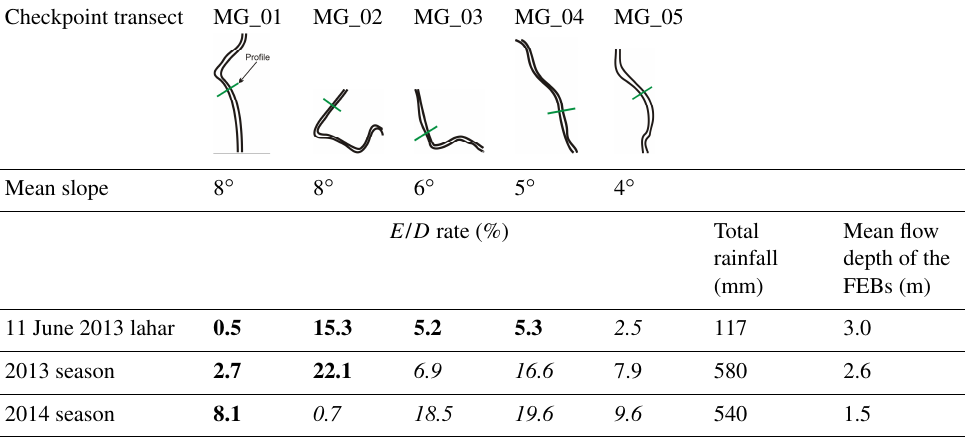
Table 2. Channel morphology at checkpoints, in relation to the E / D ( E in bold, D in italics) rates, flow depths and annual rainfall for the 11 Table II. Channel morphology at checkpoints, in relation to the E/D rates, flow depths and annual rainfall for June 2013 lahar and the 2013–2014 seasons. Table II. Channel morphology at checkpoints, in relation to the E/D rates, flow depths and annual rainfall for 575 Table II. Channel morphology at checkpoints, in relation to the E/D rates, flow depths and annual rainfall for 575 Table II. Channel morphology at checkpoints, in relation to the E/D rates, flow depths and annual rainfall for 575